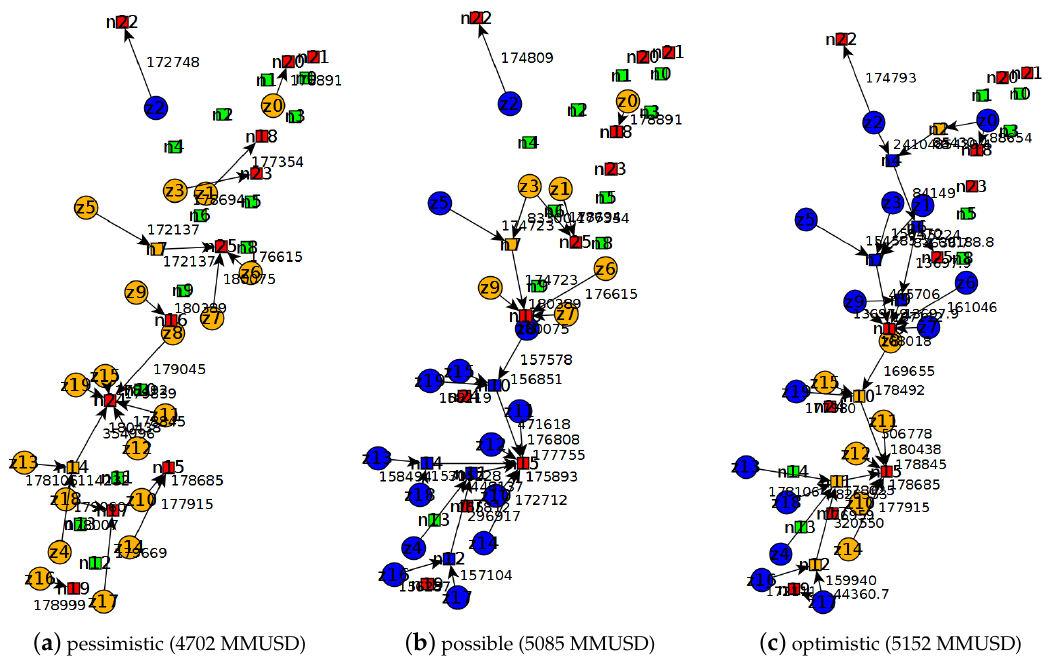
Figure 12. Generation, Transmission, Storage Energy Location and Sizing Problem (GTSELSP) solutions when using PHS technology and considering three spot price scenarios (squares = substations ( V 2 ∪ O ); circles = generation zones ( V 1 ); green = unselected; orange = selected; red = sales node ( O ); blue = storage system). ( a ) pessimistic (4702 MMUSD; ( b ) possible (5085 MMUSD); ( c ) optimistic (5152